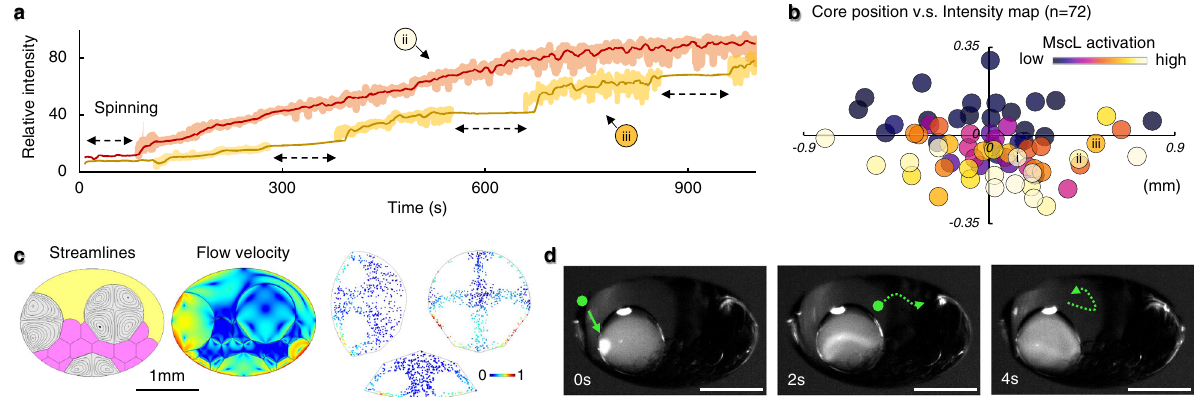
Fig. 6 MscL gating behaviours in levitated ACDC droplets. a Repeat activation and deactivation of MscL gating in levitated arti fi cial cells with distributed cores (ACDC droplet) can be achieved by repeated lock/spin operations. The orange trace shows an ACDC droplet experiencing one cycle of spin/lock operation, enabling ionic communication (Experiment labelled (ii) in b ). The yellow trace shows an ACDC droplet experiencing four sequential cycles of spin/lock operation, enabling repeated activation and shut-down of ionic communication within the ACDC droplet. The relative fl uorescence intensity did not increase during the spin intervals (each ~100 s), indicating the MscL channels were mostly deactivated during these periods and activated on application of the magnetic lock. (Experiment labelled (iii) in b ). b Relationship of core position and MscL activity: Heatmap depicting the relative rate of ion fl ux (rate of fl uorescence increase) for MscL-containing cores and their positions within different ACDC droplets (x/y offset from ACDC droplet centre). The plot origin is the centroid of each levitated ACDC droplet, and each circular data point represents a separate experiment with the circle ’ s coordinates corresponding to each MscL-containing core position relative to the centroid of the host ACDC droplet. Marker colour indicates relative activity. Markers i, ii and iii correspond to the individual traces shown in Figs. 5c and b. c Finite element modelling of acoustic streaming induced convective fl ow patterns in the cores (grey) at different positions within a locked, levitated ACDC droplet. Left: convective fl ow streamlines in the cores. Middle: fl ow velocity magnitude (logarithmic scale) within the ACDC droplet. Right: Particles (5 µ m) distribution under the convective fl ow within the cores. These simulations show how acoustic streaming pro fi le varies with core position, corroborating experimental fi ndings in b . d Experimental time sequence images over 4 s show local Ca 2 + release through MscL channels at the membrane followed by dissipation of the fl uorescence with acoustic streaming fl ow (corresponding to fl ow simulations in c ). Such hot-spots of MscL activation were observed stochastically in regions and periods of high induced local tension. Green spots and arrow dotted lines indicate the fl ow direction. Scale bars = 1